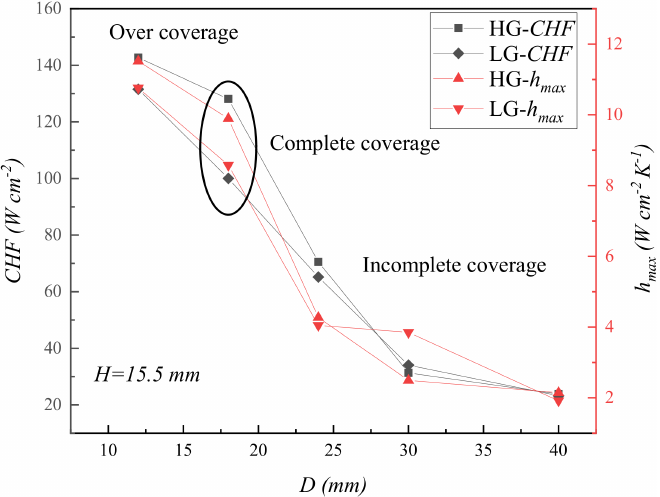
Figure 14. CHF and h max versus D at H = 15.5